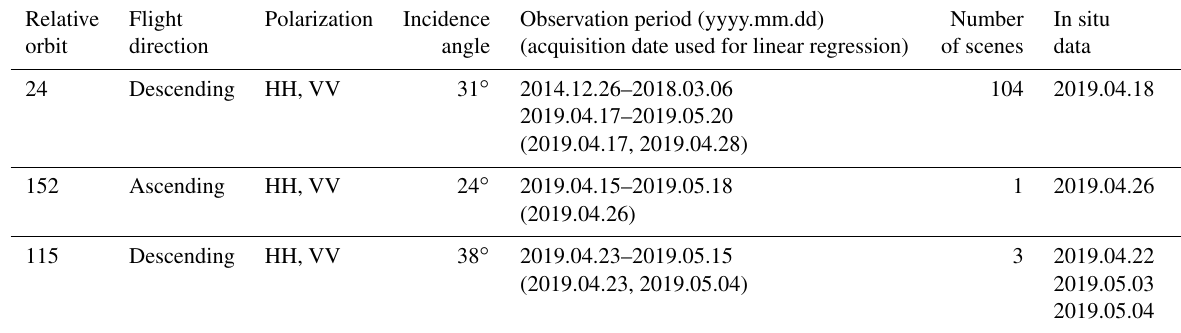
Table 2. TSX acquisition on Qikiqtaruk/Herschel Island. All orbits were used for linear regression with in situ snow measurements. Orbit 24 has a sufficient time series and was used to extract temporal evolution of CPD. Relative Flight Polarization Incidence Observation period (yyyy.mm.dd) Number In situ orbit direction angle (acquisition date used for linear regression) of scenes